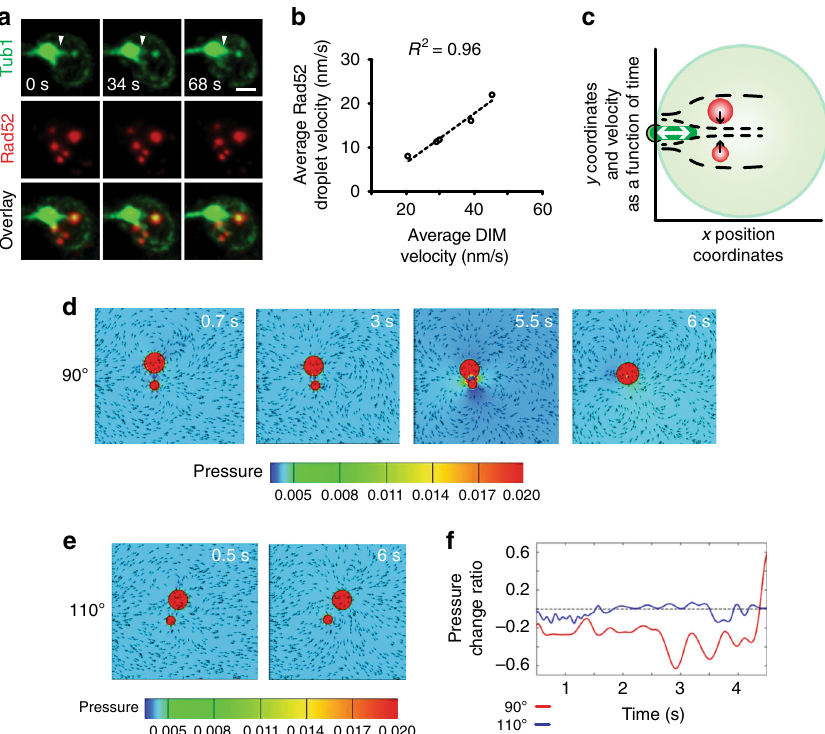
Fig. 3 Rad52 droplet fusion can be promoted by fl ow-generating short nuclear microtubules. a , b pti-DIM extension/shortening ( a , white arrowhead) correlates with Rad52 droplet velocity ( a , b ). c – f CFD-based modelling of pti-DIM motion shows that it can generate fl ow that drives Rad52 droplet fusion when pti-DIM velocity is applied at ~90° ( d ) but not at 110° ( e ) relative to the axis connecting the centre of the droplets. Fusion is driven by an inter-droplet decrease in pressure that is shown in gradients ( d , e ) and quanti fi cations ( f ). Scale bar, 1 µ m.